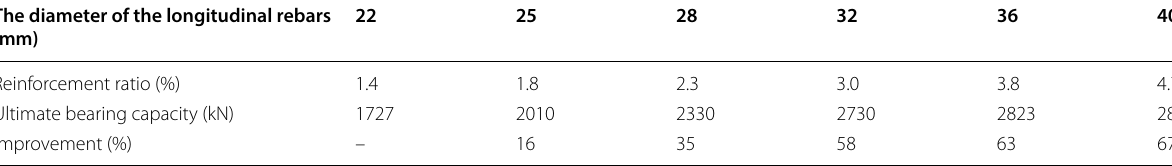
Table 5 Ultimate bearing capacity for different reinforcement